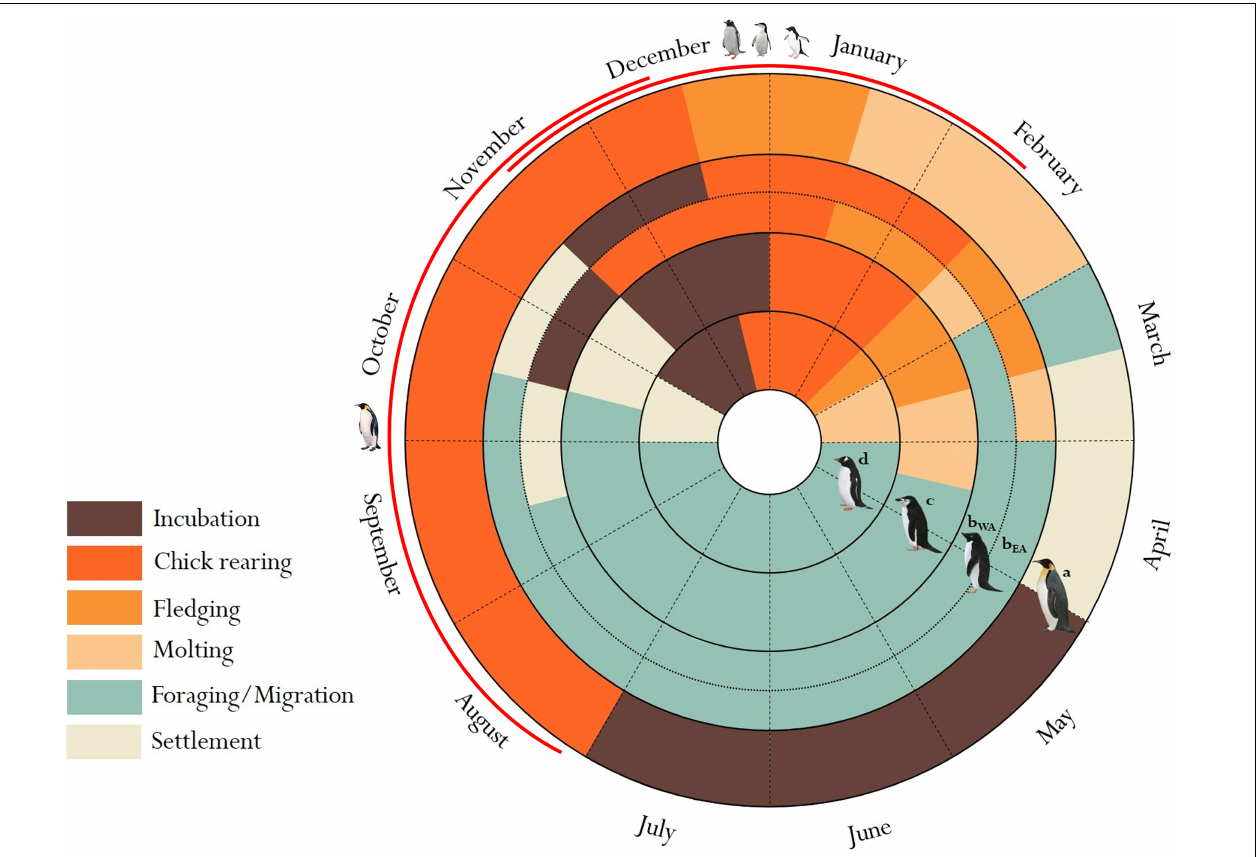
FIGURE 1 | Adult penguin life cycles of the four species of penguin breeding in Antarctica: Emperor (a), Adélie – West Antarctica (b WA ), Adélie – East Antarctica (b EA ), Chinstrap (c) and Gentoo (d) penguin, and key chick-rearing months when species have the most restricted range (red); the period for which marines IBAs were identified. Figure adapted from Emmerson et al. (2011), Lynch et al. (2012), Borboroglu and Boersma (2013), Black (2016). The figure is based on the most common reports for mainland Antarctica but variations in the start of laying dates (some of which are linked to latitude) have been observed for species by up to 2 weeks (Ainley, 2002; Emmerson et al., 2011; Black, 2016; Youngflesh et al.,